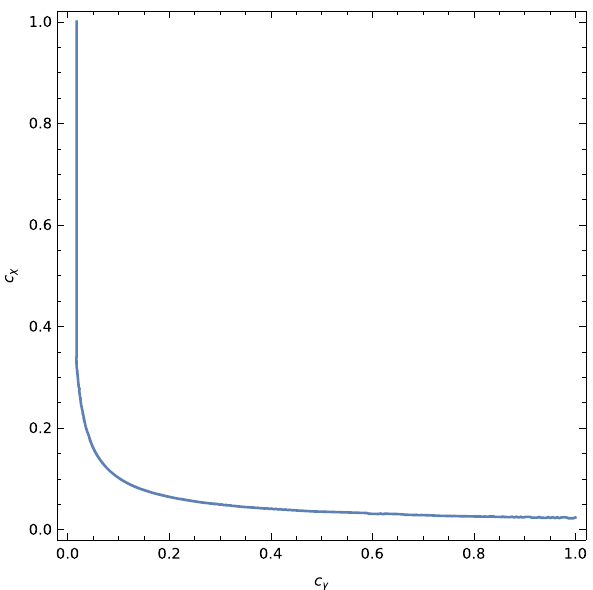
Fig. 1 The correlation between c γ and c χ for large contribution of reheating sourced two point correlation